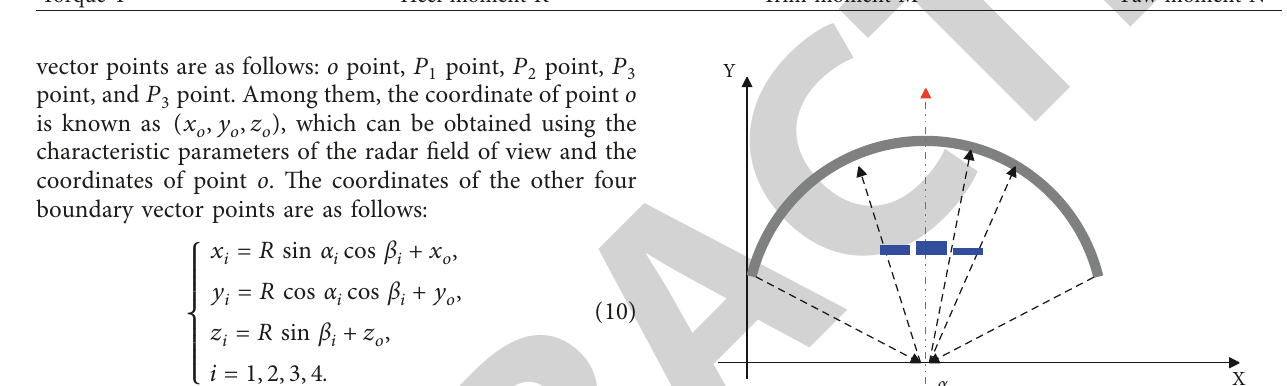
Figure 2: Schematic diagram of the grid representation of forward- looking radar